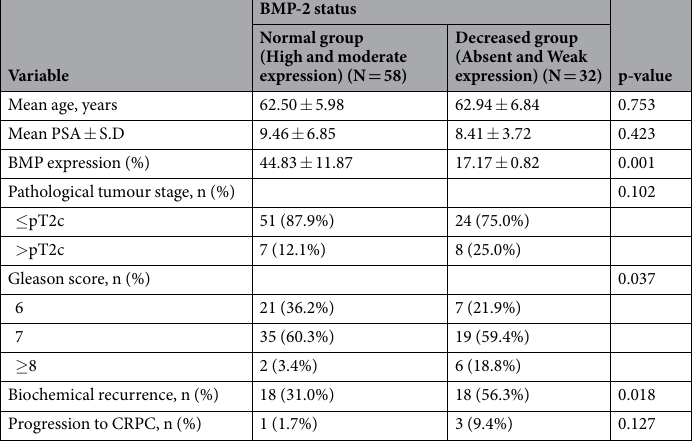
Table 3. Association of decreased BMP-2 expression with clinicopathological characteristics in 90 patients treated with radical prostatectomy for prostate cancer. PSA = prostate specific antigen; BMP = bone morphogenetic proteins; S.D = standard deviation; CRPC = castration resistance prostate cancer.